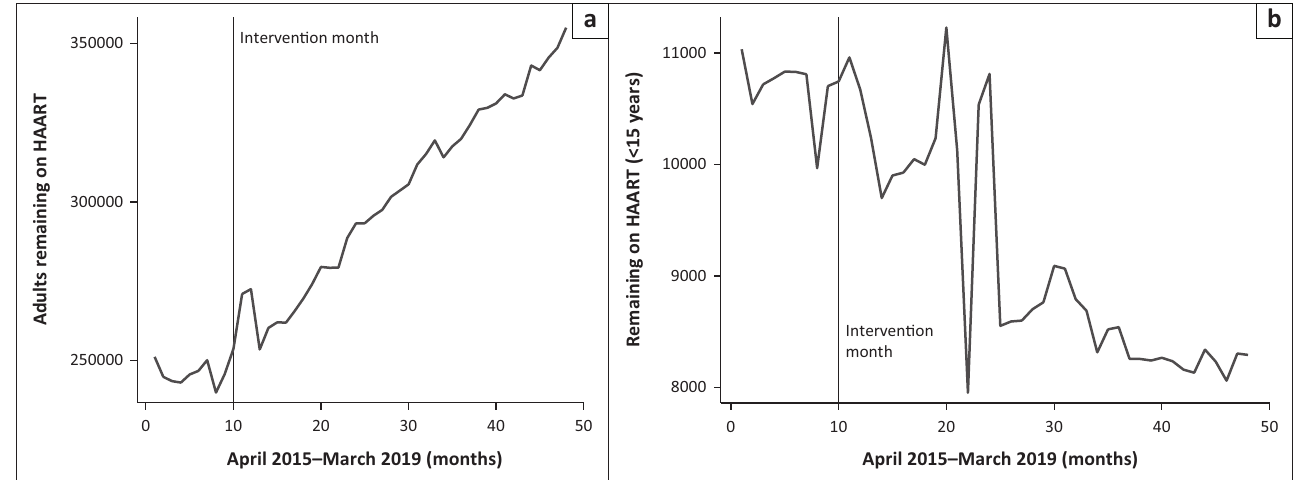
FIGURE 2: (a) Trends in adults monthly retention on antiretroviral treatment and (b) trends in < 15 years monthly retention on antiretroviral treatment.